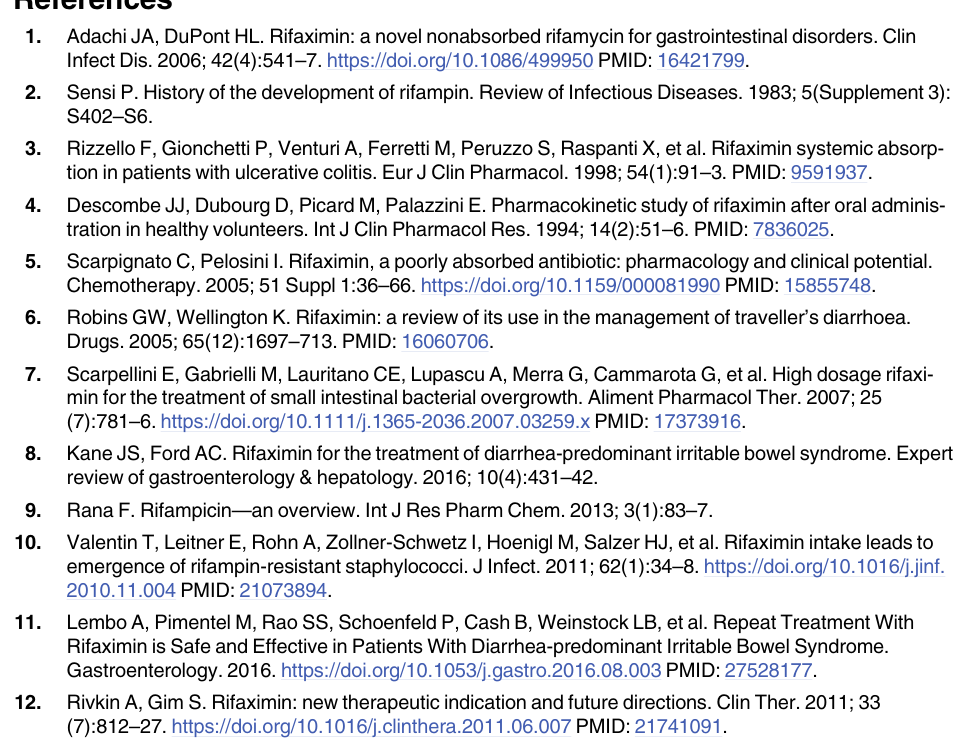
S1 File. Data of enrolled patients. This file contains clinical characteristics of enrolled patients used for this study. Information identifying the individual has been